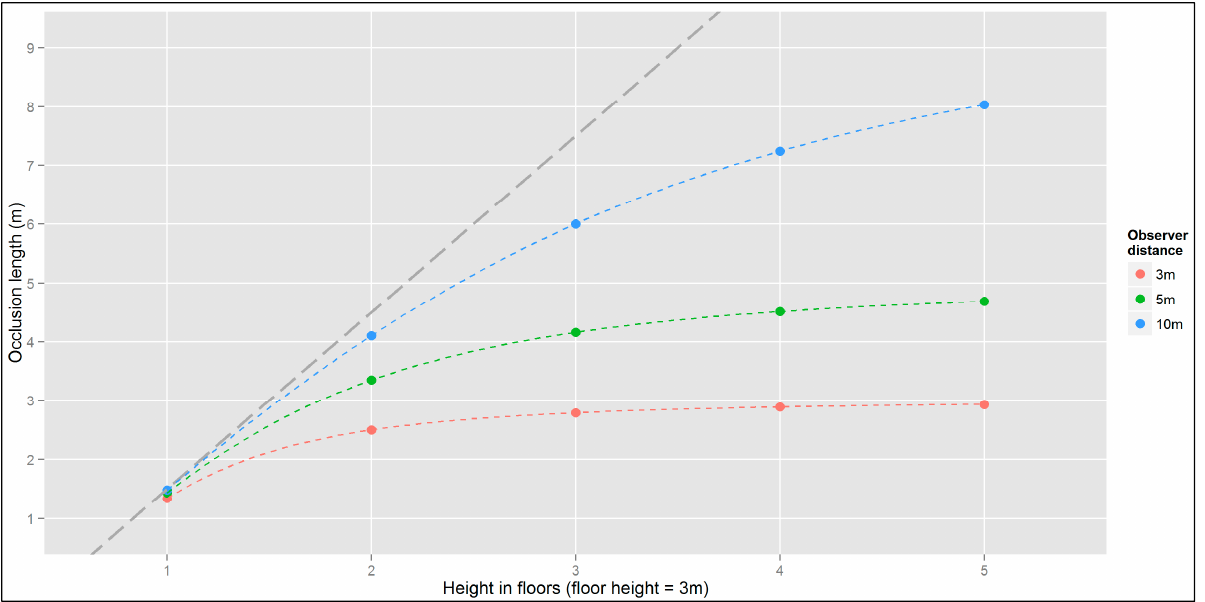
Figure 6. Apparent occlusion for floors 1 to 5 depending on observer distance to façade.